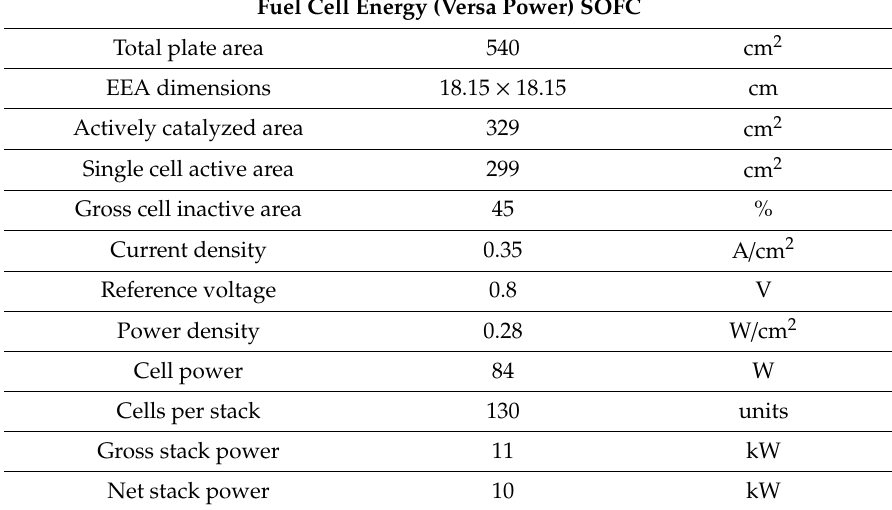
Table 2. Characteristics of SOFCs manufactured by Versa Power; authors’ own elaboration of data from [40,57].